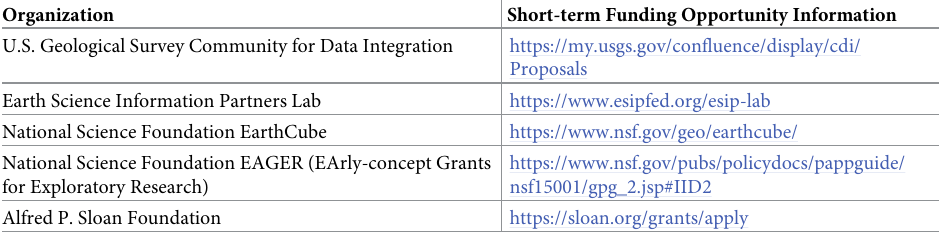
Table 1. Examples of short-term seed funding opportunities that are available for Earth science informatics